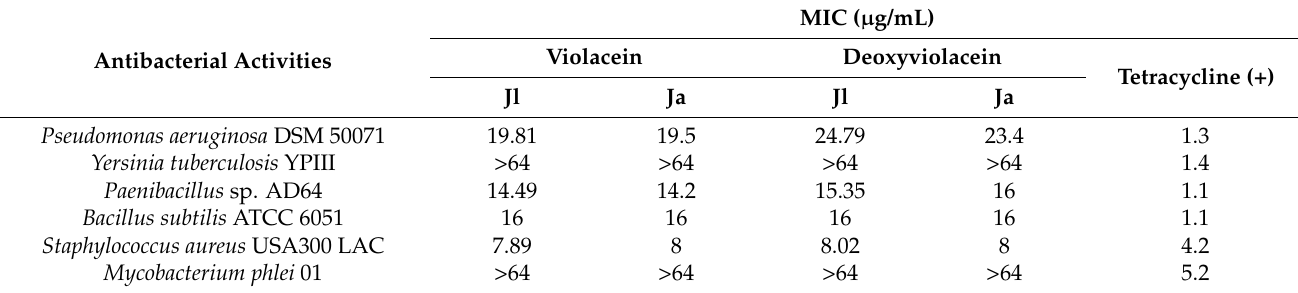
Table 3. Antibacterial activities of violacein and deoxyviolacein from Janthinobacterium strains against pathogenic